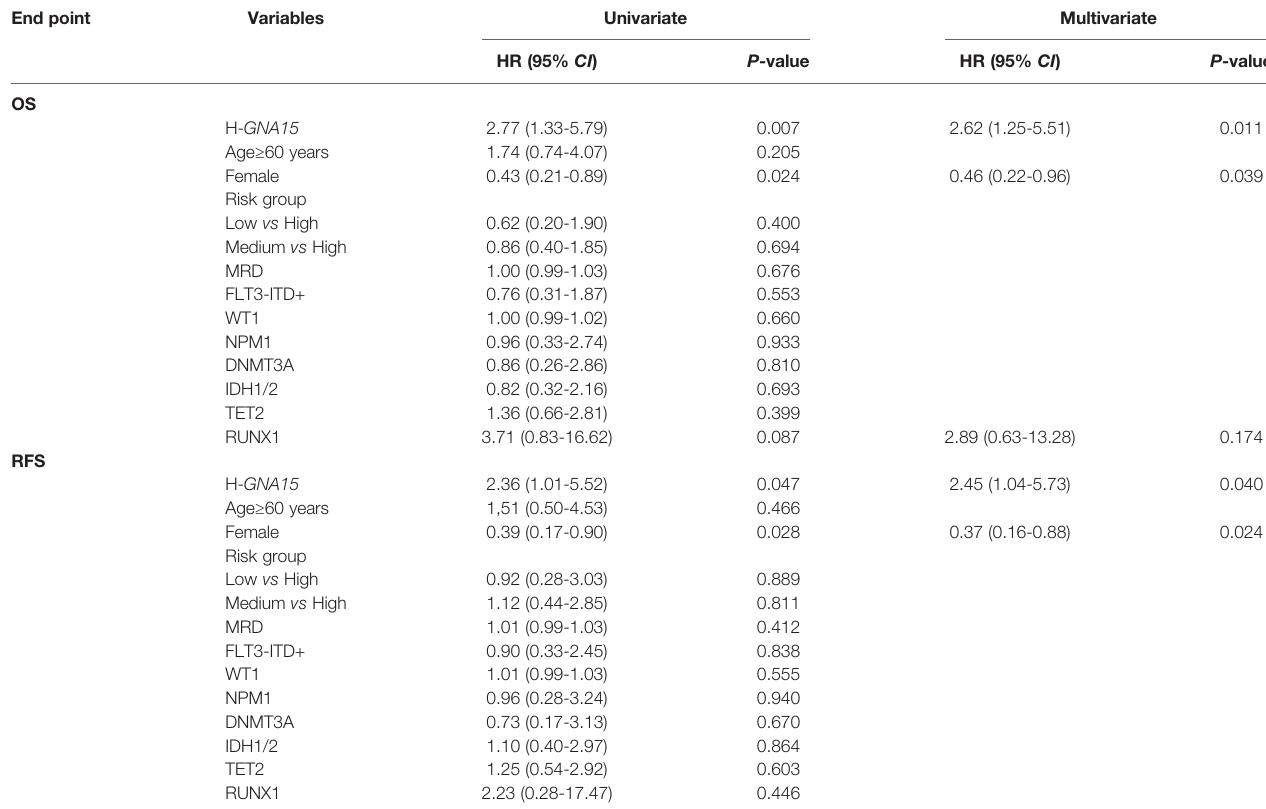
TABLE 2 | Univariate and Multivariate Analysis of OS and RFS in AML with Normal Karyotype. End